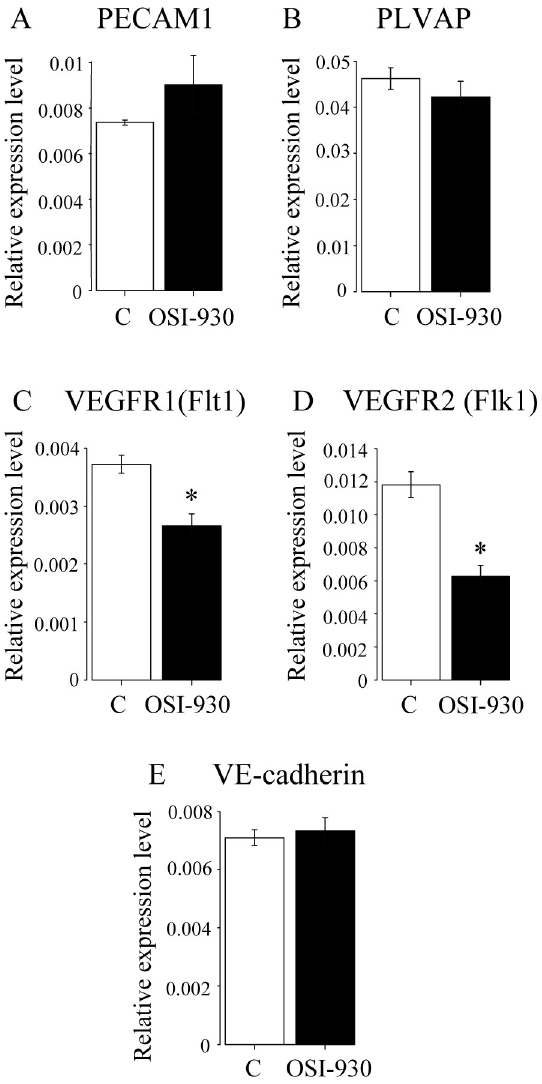
Fig 4. Quantitative real-time RT-PCR analysis of vascular markers. Expression levels of PECAM1 (A), PLVAP (B), VEGFR1 (C), VEGFR2 (D), and VE-cadherin (E) were analyzed. Actb was used as a control ( � P < 0.05, t-test).